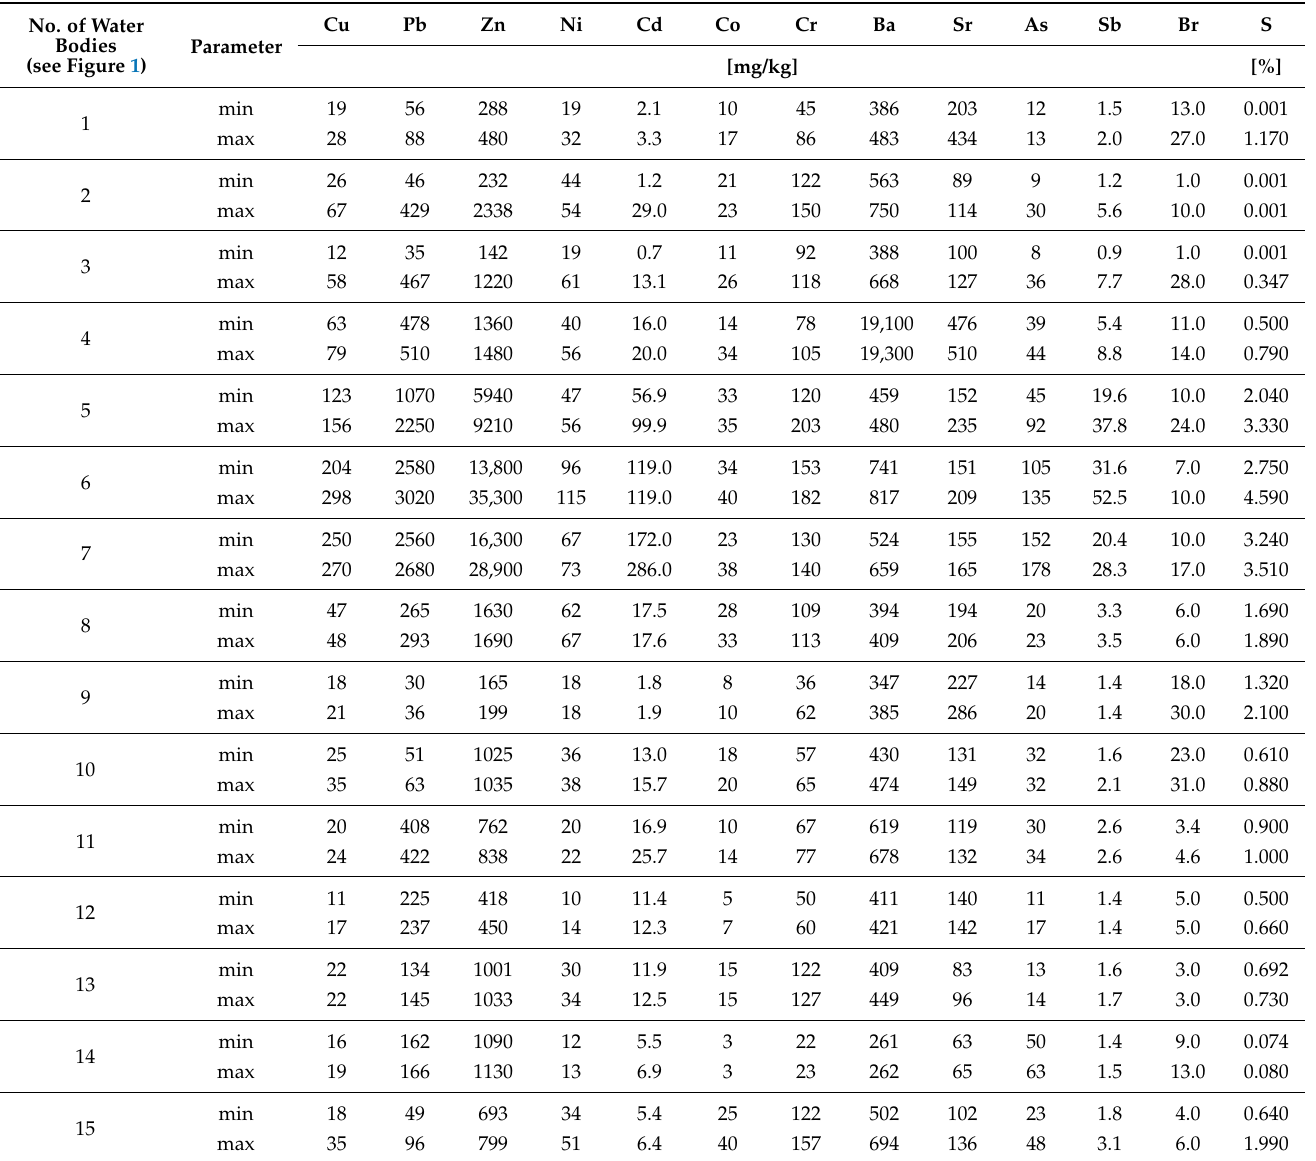
Table 3. Concentrations of metals, non-metals and metalloids in the bottom sediments of water bodies used for recreational purposes in the Silesian Upland and its